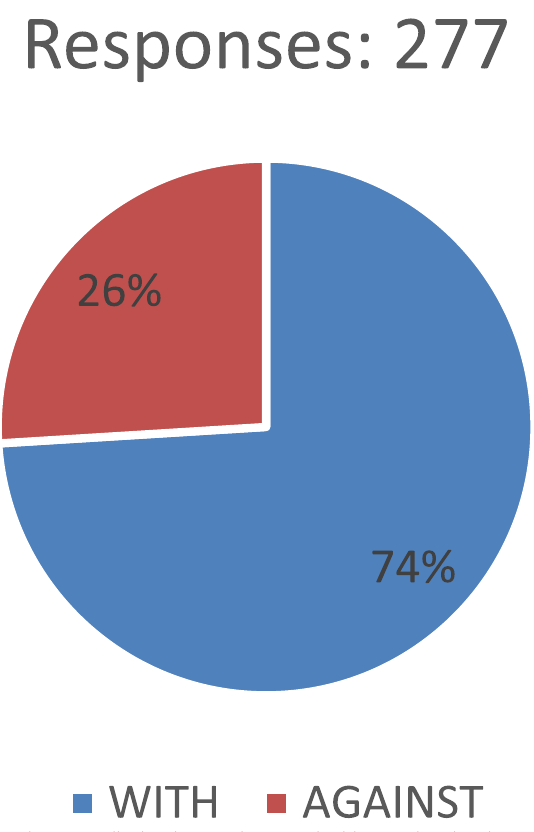
Fig. 8 The priority is to design smaller local spaces between buildings rather than large open spaces